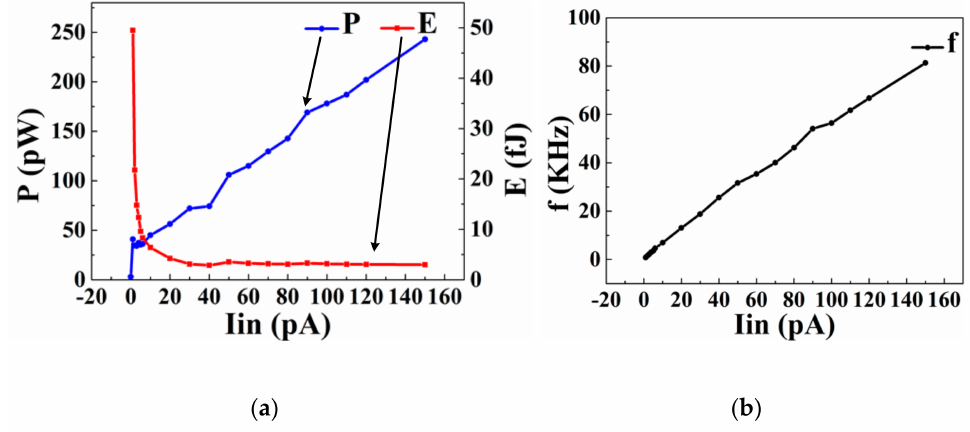
Figure 9. Power consumption and the output frequency results of neural circuits. ( a ) The variation of the power P and spike energy E with the input current. ( b ) The variation of the spike frequency with the input current.